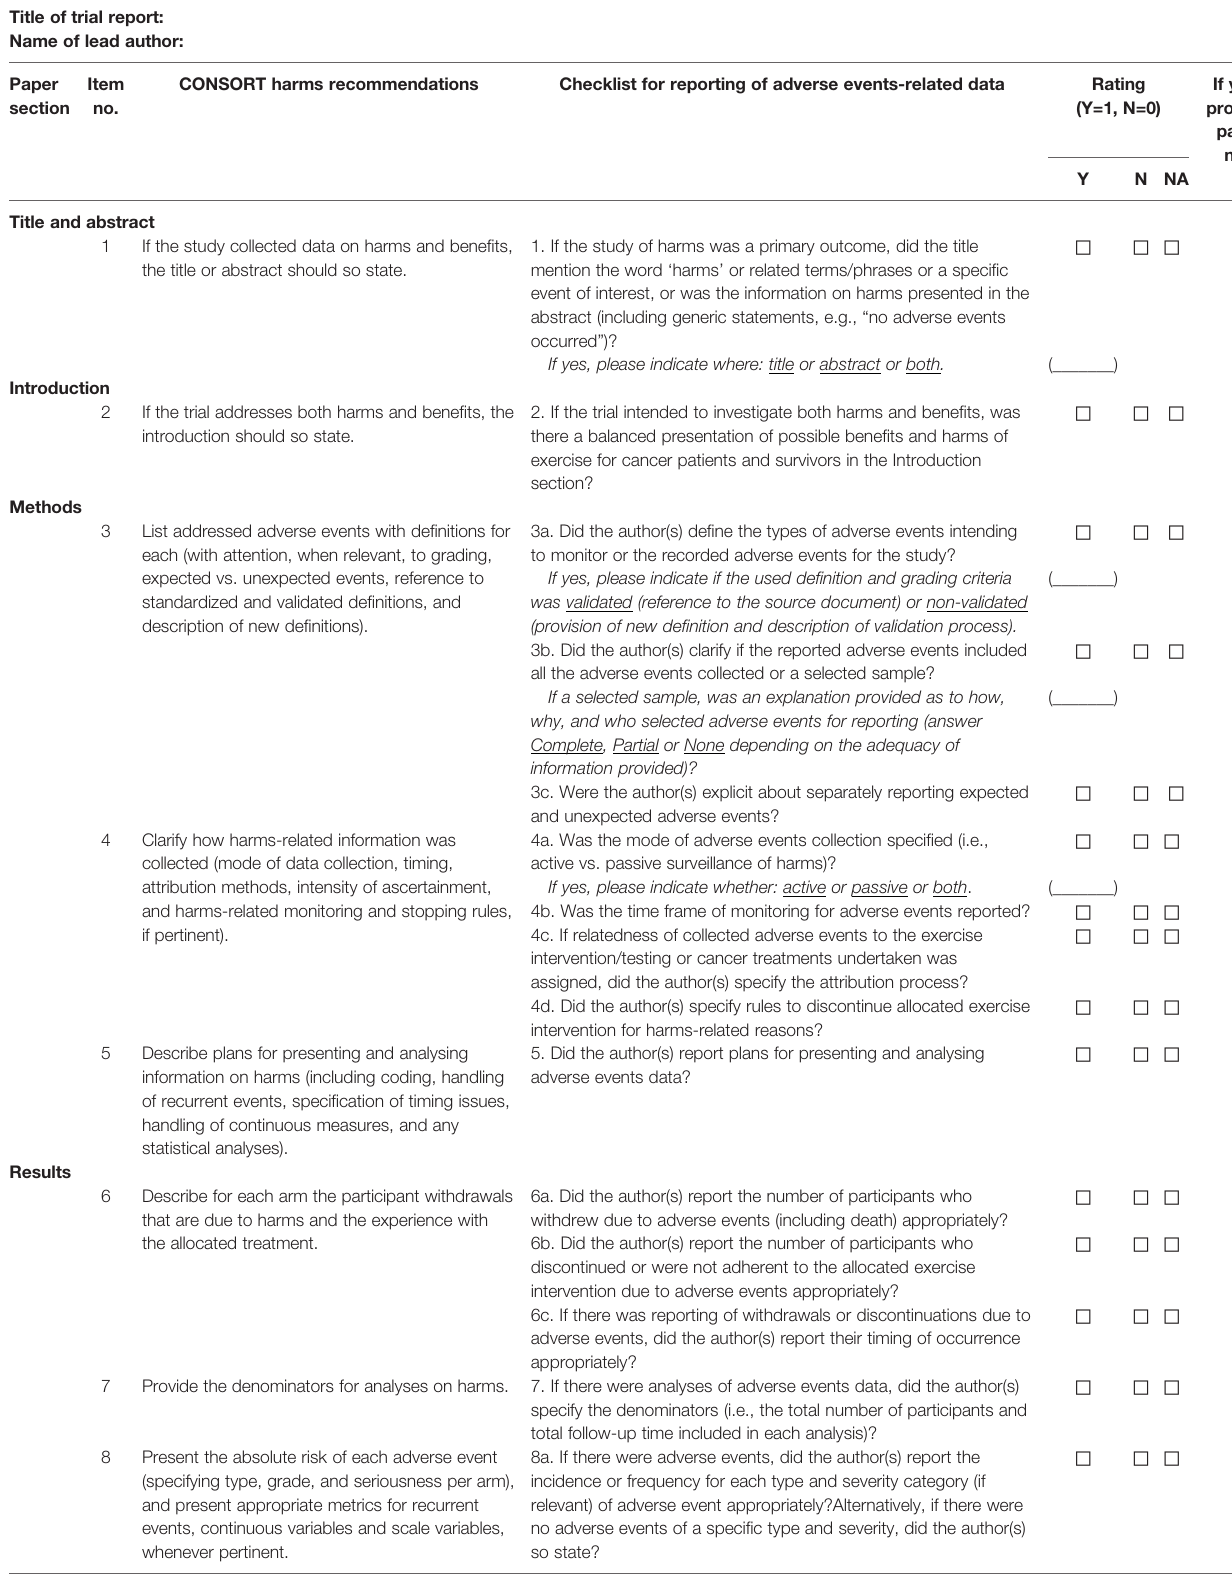
TABLE 3 | Adverse events-related data extraction